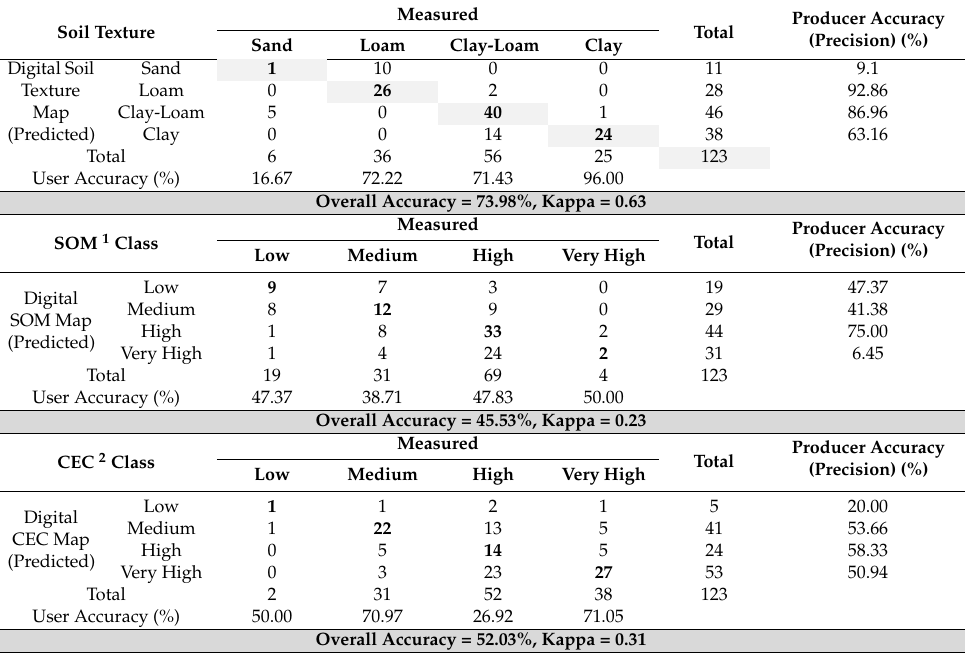
Table 4. Confusion matrix tables between measured versus predicted soil